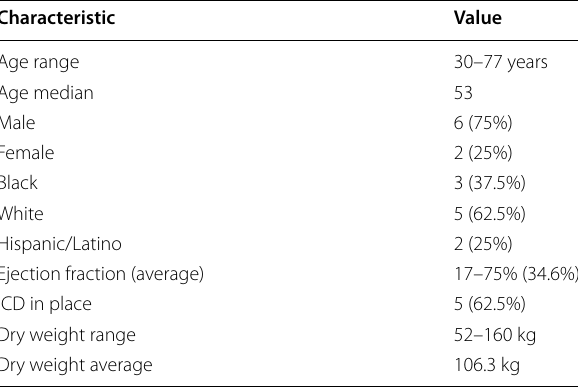
Table 1 Patient